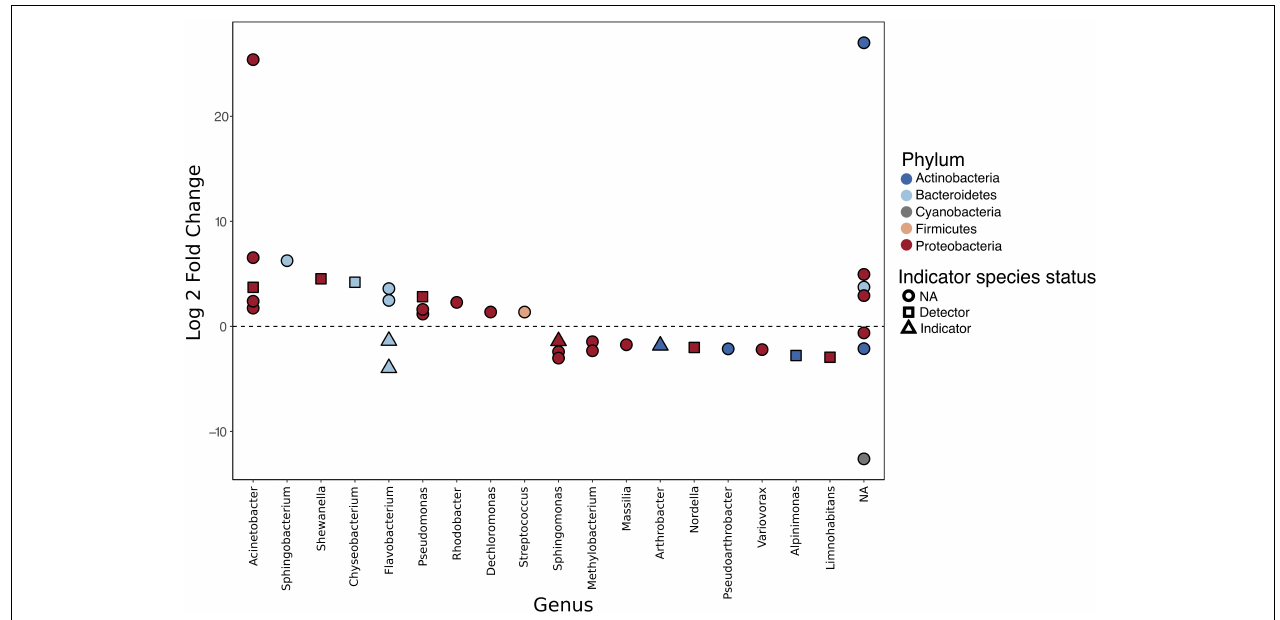
FIGURE 4 | Differentially abundant sequence variants (SVs) identified using DESeq2. A positive log 2 fold change indicates that an SV is enriched in ranavirosis-positive populations and a negative log 2 fold change that the SV is enriched in disease-free populations. The results of our indication species analysis are overlaid. Circular points denote an SV with an indicator species score of < 0.5, suggesting poor association between that SV and a disease history group. Square points denote SVs with an indicator score of 0.5–0.7. Such SVs are considered detector species and have a suggestive but not indicative relationship with the disease history group in which they are enriched. Triangular points indicate SVs with an indicator species score of 0.7 or greater. These SVs are considered indicator species of the disease history group in which they are